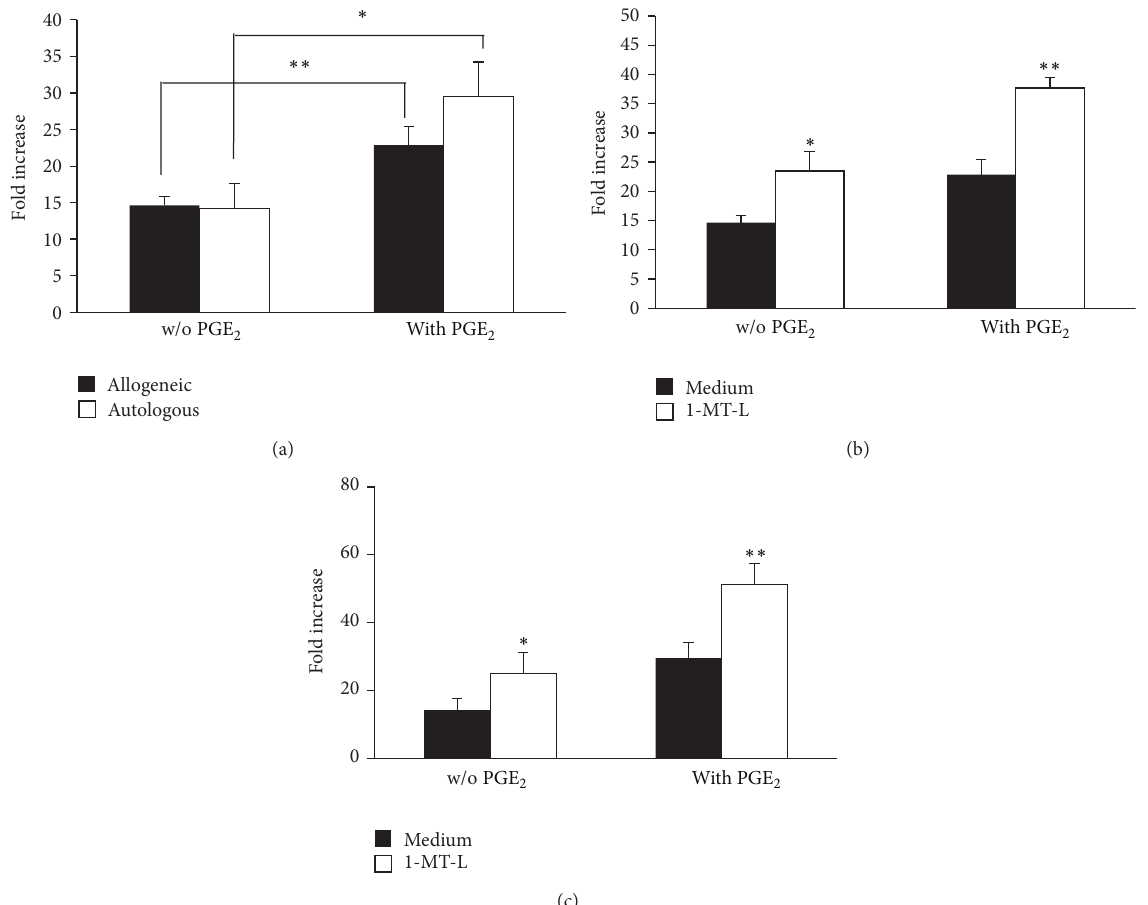
Figure 2: IDO1 expression inhibited the stimulatory capacity of mature DCs. (a) DCs matured with the cytokine cocktail without PGE 2 (expressing low IDO1) or complete of PGE 2 (expressing high IDO1) were used as stimulator of either allogeneic or autologous CD3 + T cells. For the stimulation of autologous CD3 + T cells, DCs were previously pulsed with tetanus toxin. ∗ 𝑃 < 0.05 , ∗∗ 𝑃 < 0.01 . Both in the allogeneic (b) and in the autologous (c) setting, the assay was performed either in presence or in absence of the IDO1-specific inhibitor 1-MT-L. The results are expressed as the mean of fold increase of 5 independent experiments ± SEM. ∗ 𝑃 < 0.05 , ∗∗ 𝑃 < 0.01 versus medium